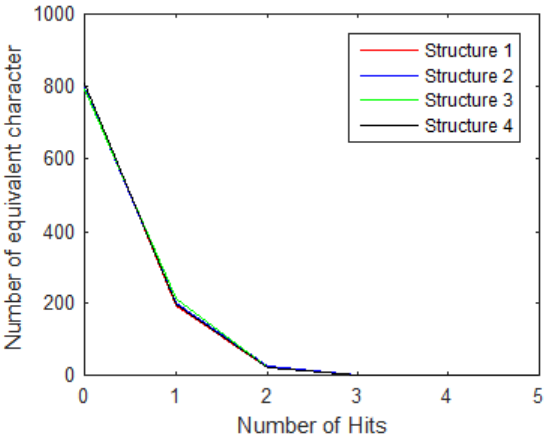
Figure 13. Distribution of the number of hits.